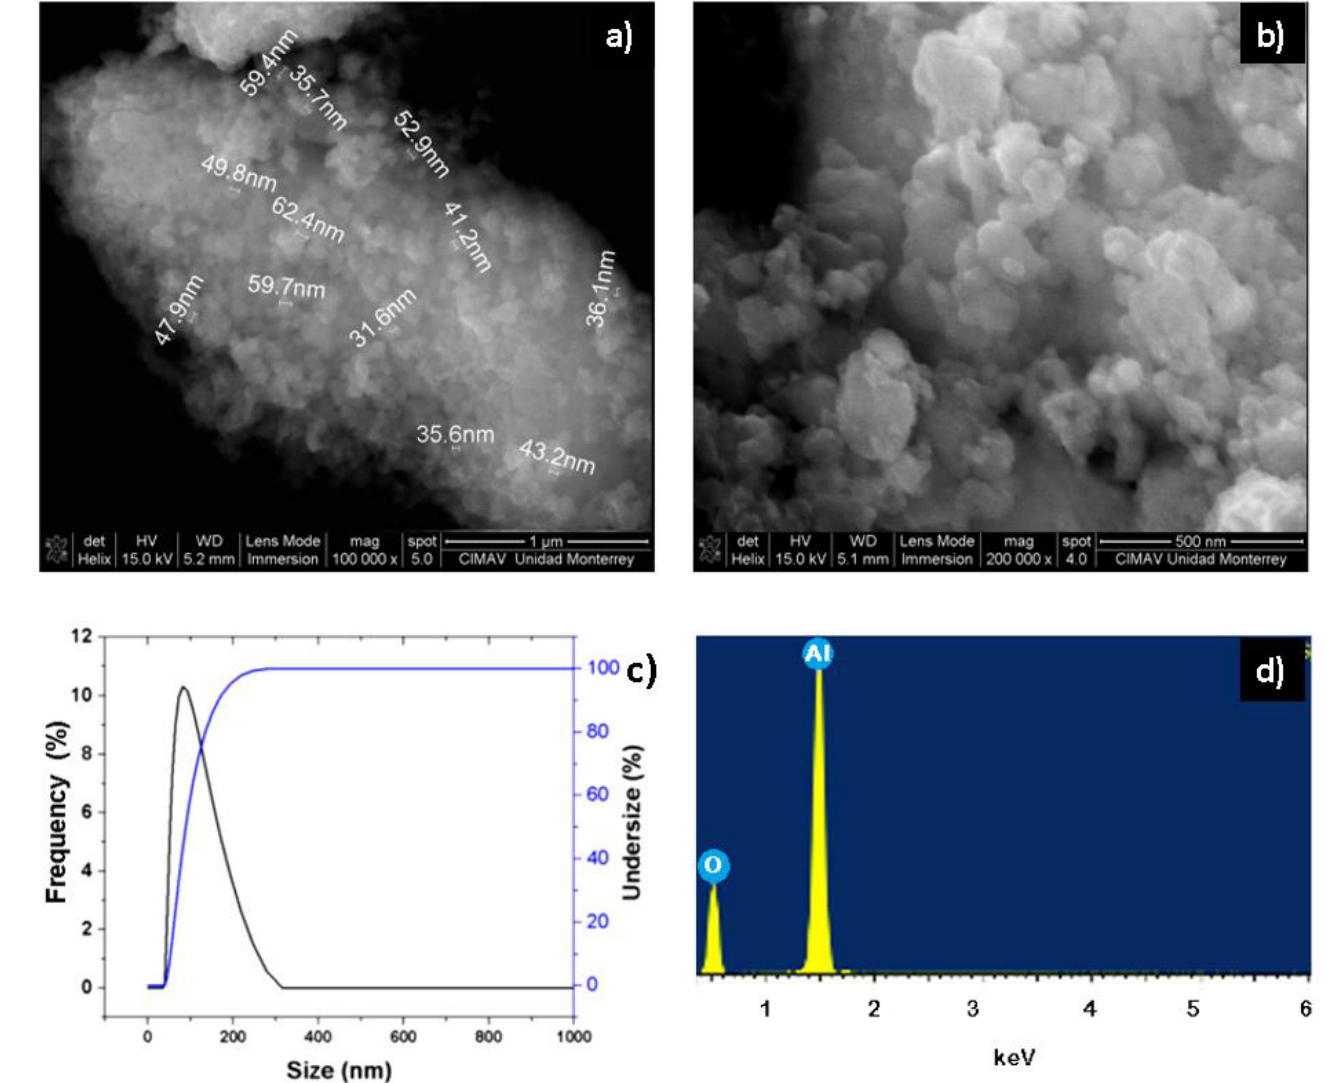
Figure 2. SEM micrographs at ( a ) 100,000 × and ( b ) 200,000 × ; ( c ) DLS and ( d ) EDX spectrum for α -Al 2 O 3 nanopowders.